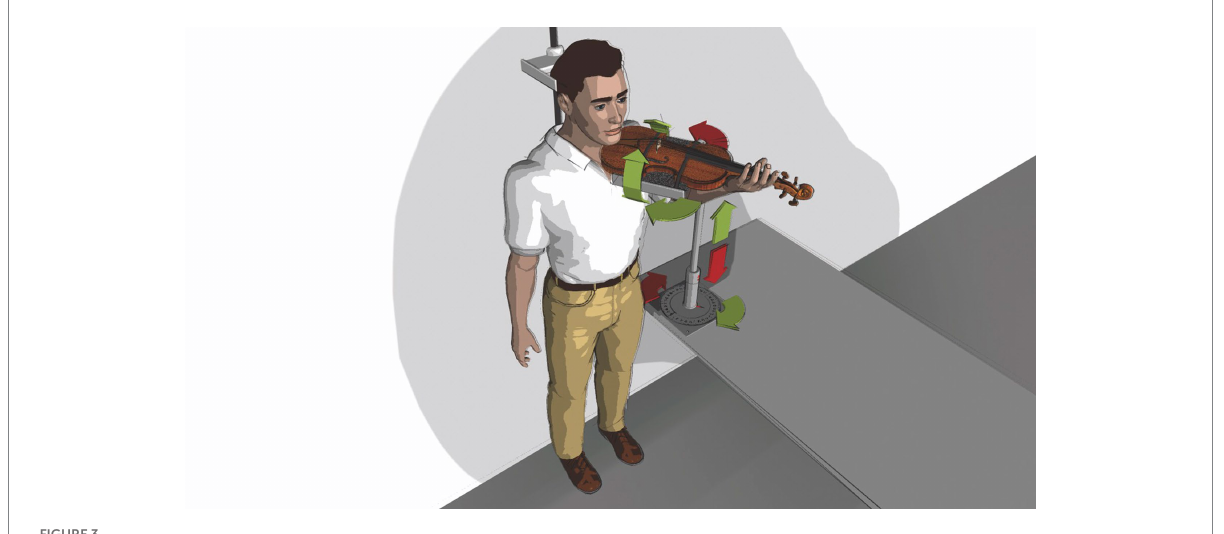
FIGURE 3 Schematic illustration of instrument fitting device in experiment